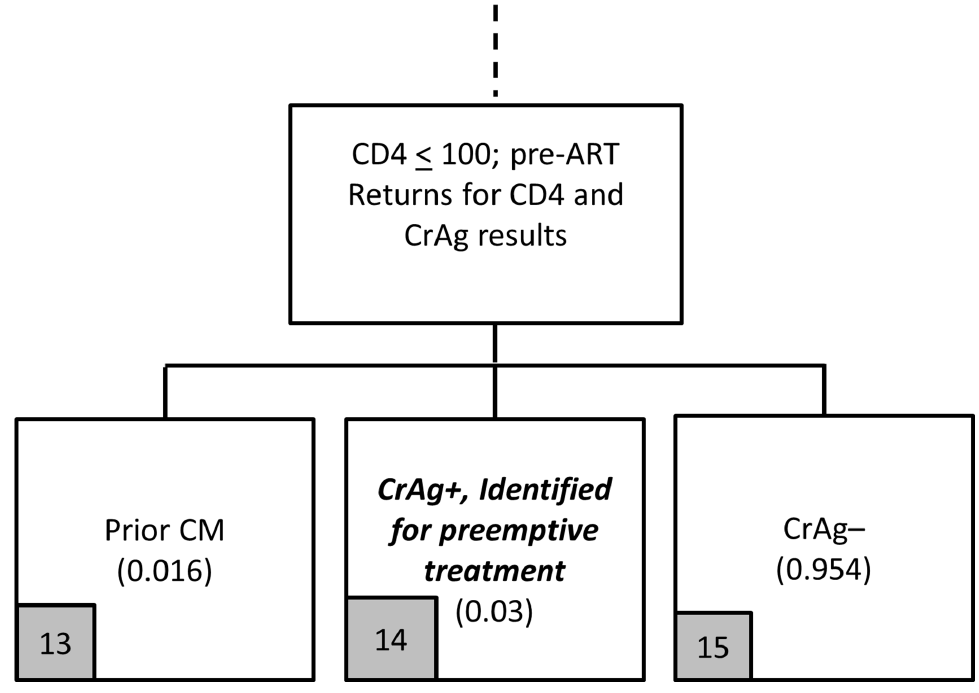
Fig 3. Reflex screening flowchart (Panel